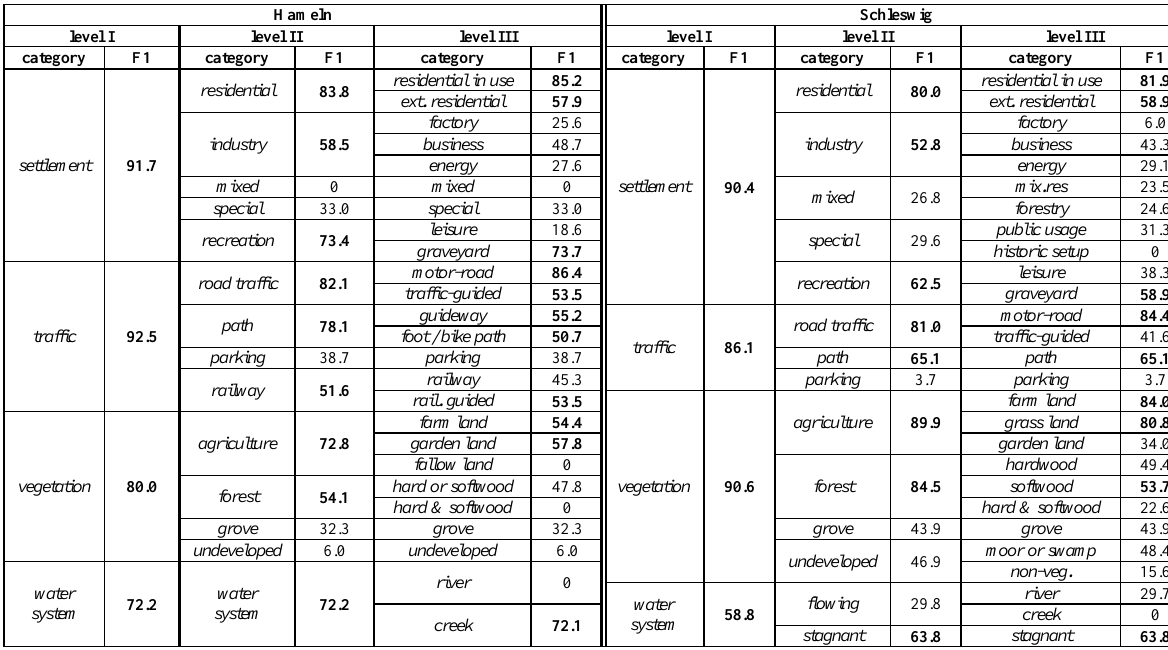
Table 3: F1 scores (%) of individual category of all levels from HierLuNet-F2C . The F1 scores over 50% are printed in bold